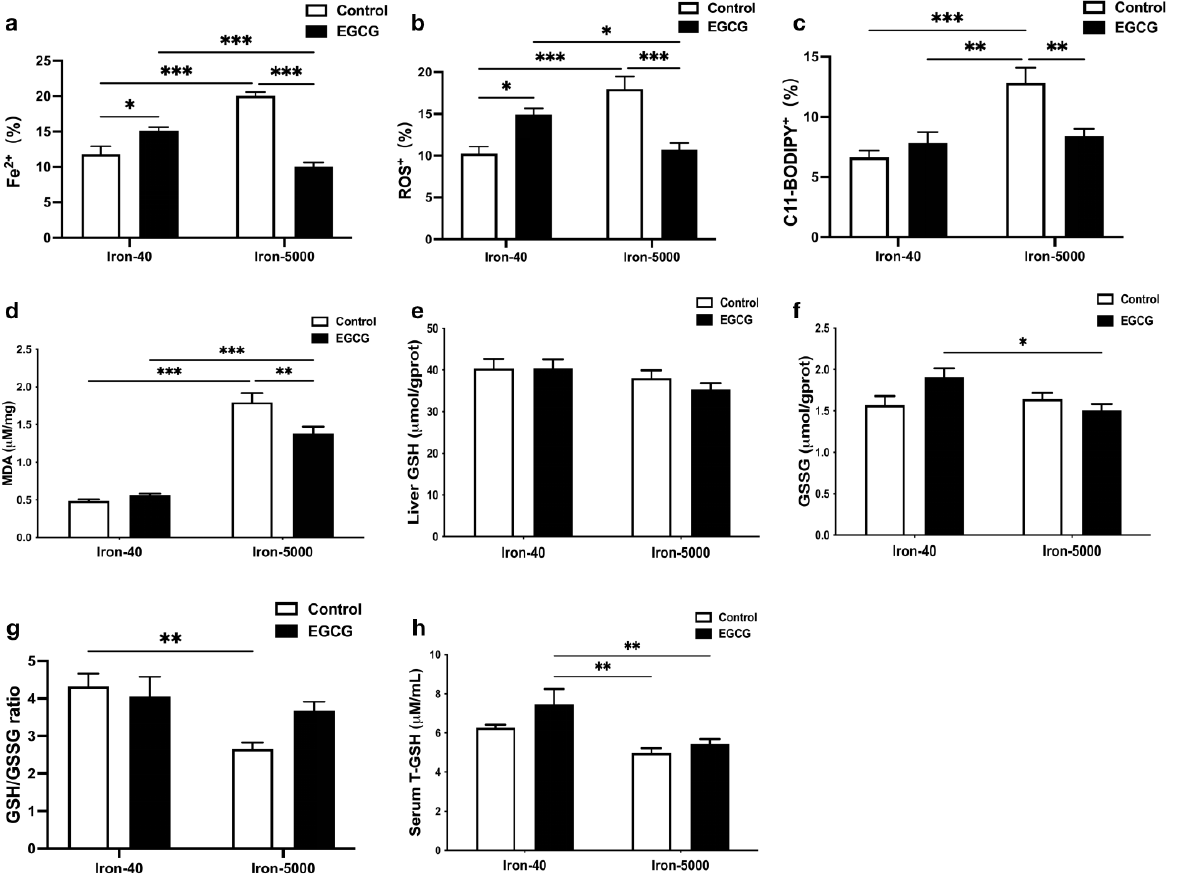
Figure 5. EGEG administration decreases liver oxidation damage in iron overload mice. ( a – c ) Level of Fe 2+ , ROS, and C11-BODYPY in the liver ( n = 8), the percentage (%) unit stands for the area percentage of Fe 2+ , ROS, and C11-BODYPY. ( d ) MDA levels in the liver ( n = 10). ( e , f ) Total GSH and GSSG levels in the liver ( n = 10). ( g ) Liver GSH/GSSG ratio. ( h ) Total GSH levels in serum ( n = 10).